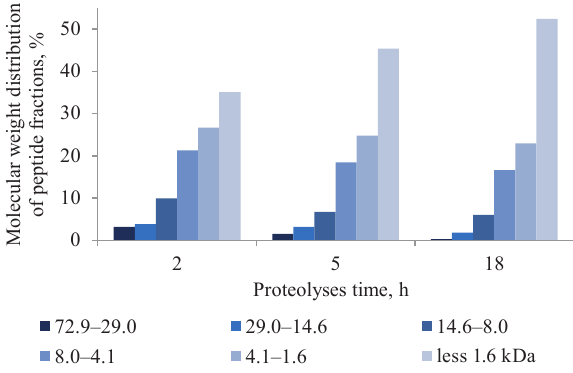
Figure 5 Molecular weight distribution of peptides during the enzymatic hydrolysis of the microbial biomass mix ( Aspergillus oryzae and Sаcharomyces cerevisiae